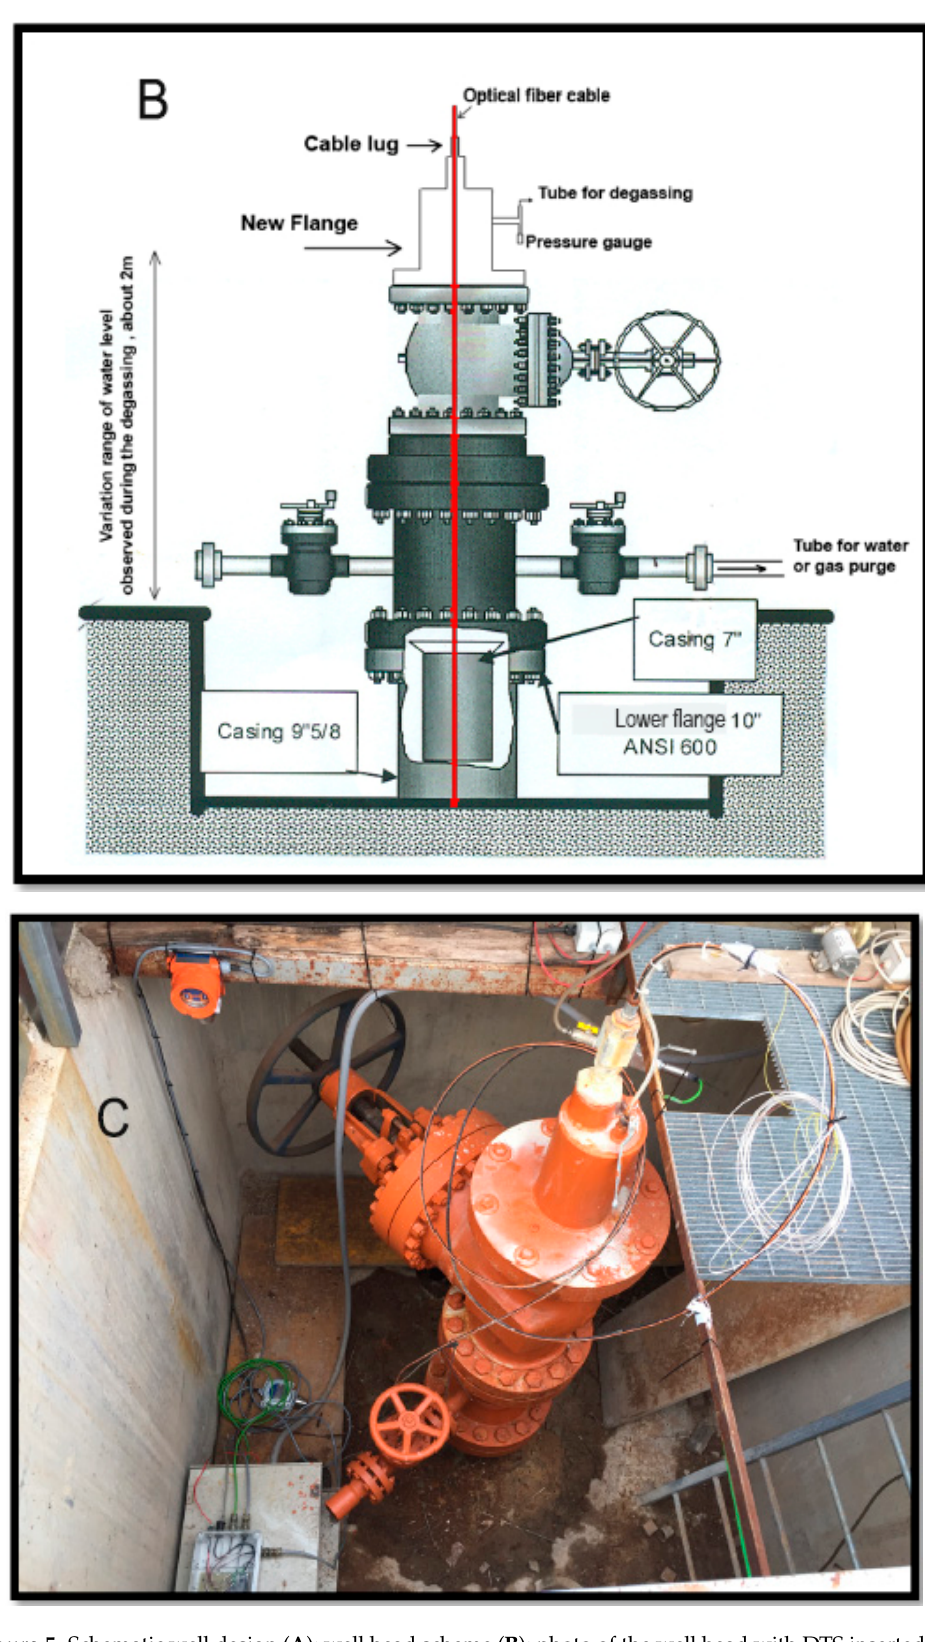
Figure 5. Schematic well design ( A ); well head scheme ( B ); photo of the well head with DTS inserted (C).